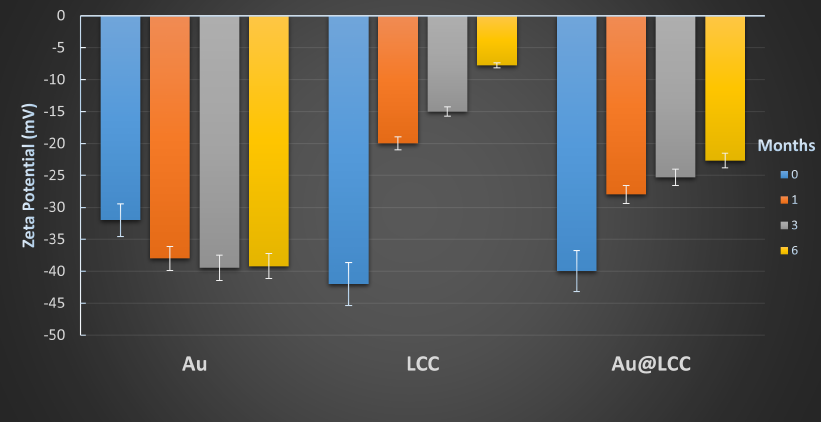
Figure 4. Zeta potential values measured for the three considered